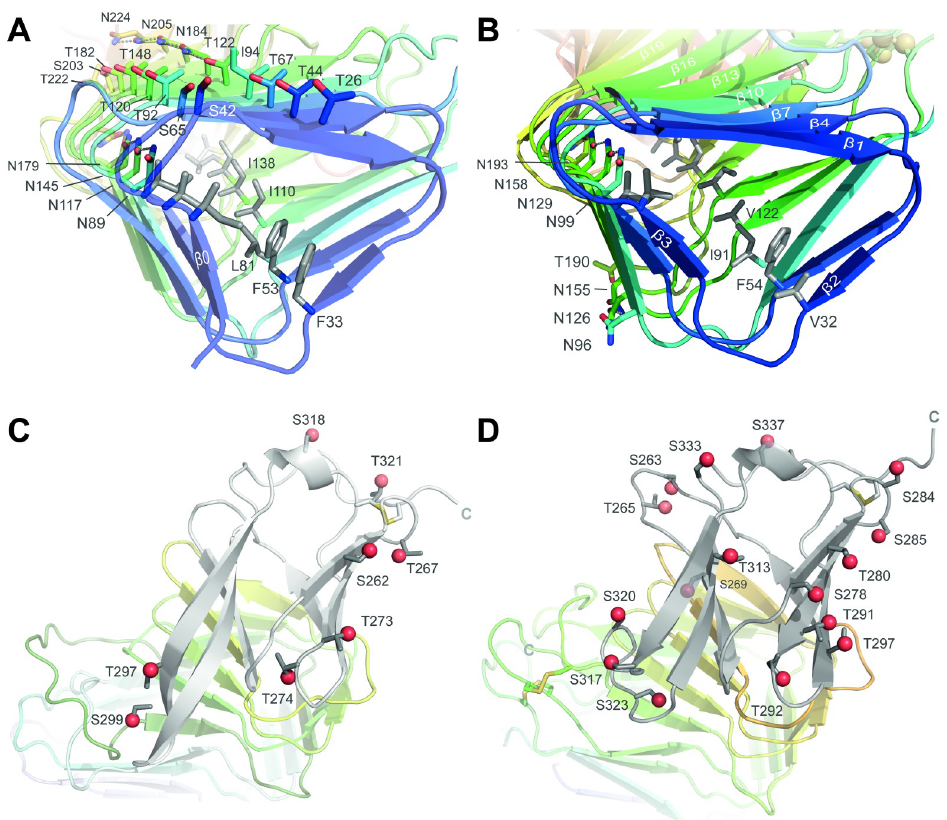
Fig 6. Stacking patterns and O -glycosylation sites within the Awp1 and Awp3b A-regions. Top, view along the β - helix domains showing the repetitive bands of hydrophobic (gray) and serine, threonine and asparagine residues (colored) along the inner and outer β -helix areas of Awp1 (A) and Awp3b (B) A-regions. Bottom, O -glycosylation sites as predicted by NetOGlyc 4.0 for the A-regions of Awp1 (C) and Awp3b (D). The hydroxyl groups to be covalently modified by a fungal oligomannan are highlighted as spheres. Only eight of nine predicted O -glycosylation sites in Awp1 (Awp3b: 16 of 17) are depicted because S254 (Awp3b: T268) is buried within the α -crystallin domain (gray) and hence unaccessible for O -glycosylation. Notably, no or only a single O -glycosylation site was predicted for both A- regions in the β -helix